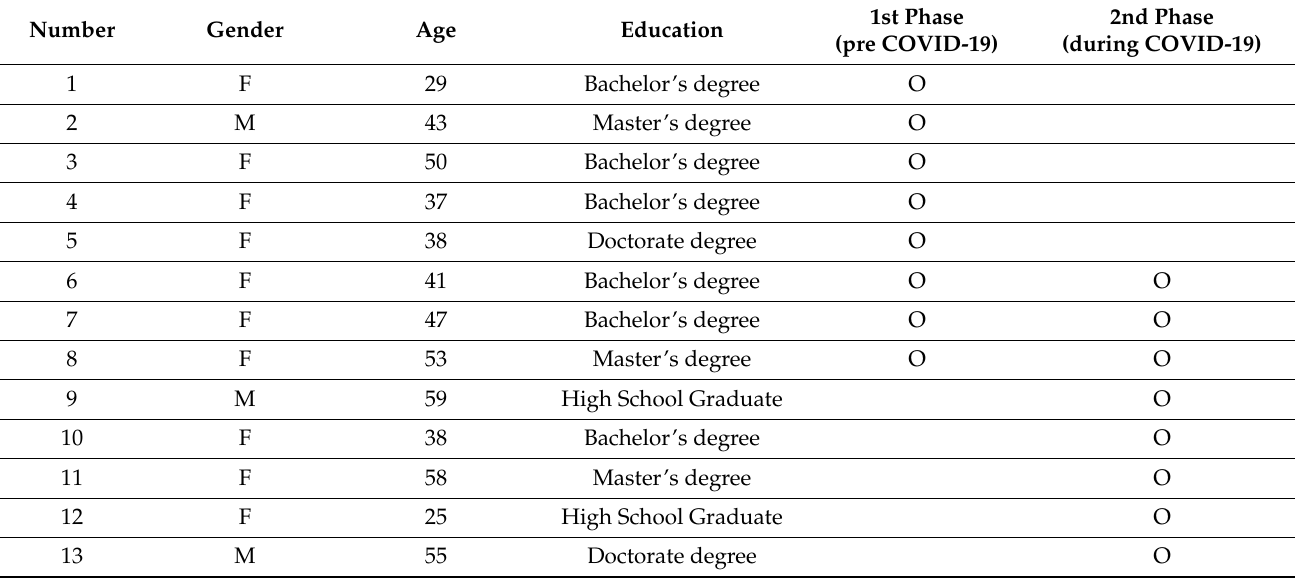
Table 3. General characteristics of participants. ( n =